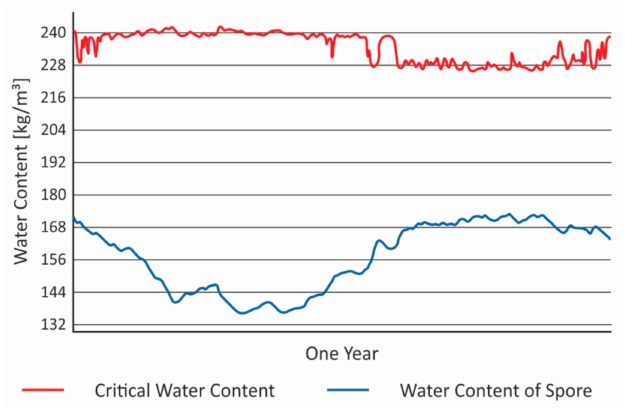
Figure 17. Changes in water content for the envelope according to the calculations for the indoor climate, EN